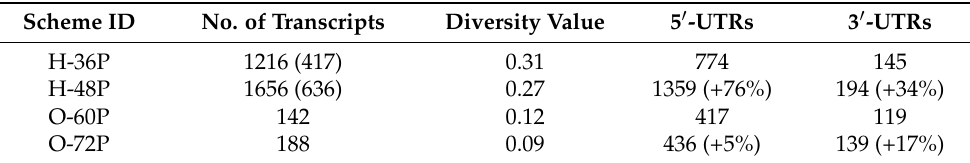
Table 2. Transcriptional dynamics. The number of different transcripts (similarity <0.99), the diversity values calculated as the ratio between variable over total viral transcripts and the lengths of 5 (cid:48) - and 3 (cid:48) -UTRs were reported for the four PacBio samples. The percentages of UTR length increase between early and late time points were reported. In parentheses beside the number of different transcripts for the two HaHV-1 samples are also indicated the different transcripts obtained considering the HaHV-1 FLNCs rarefied to OsHV-1